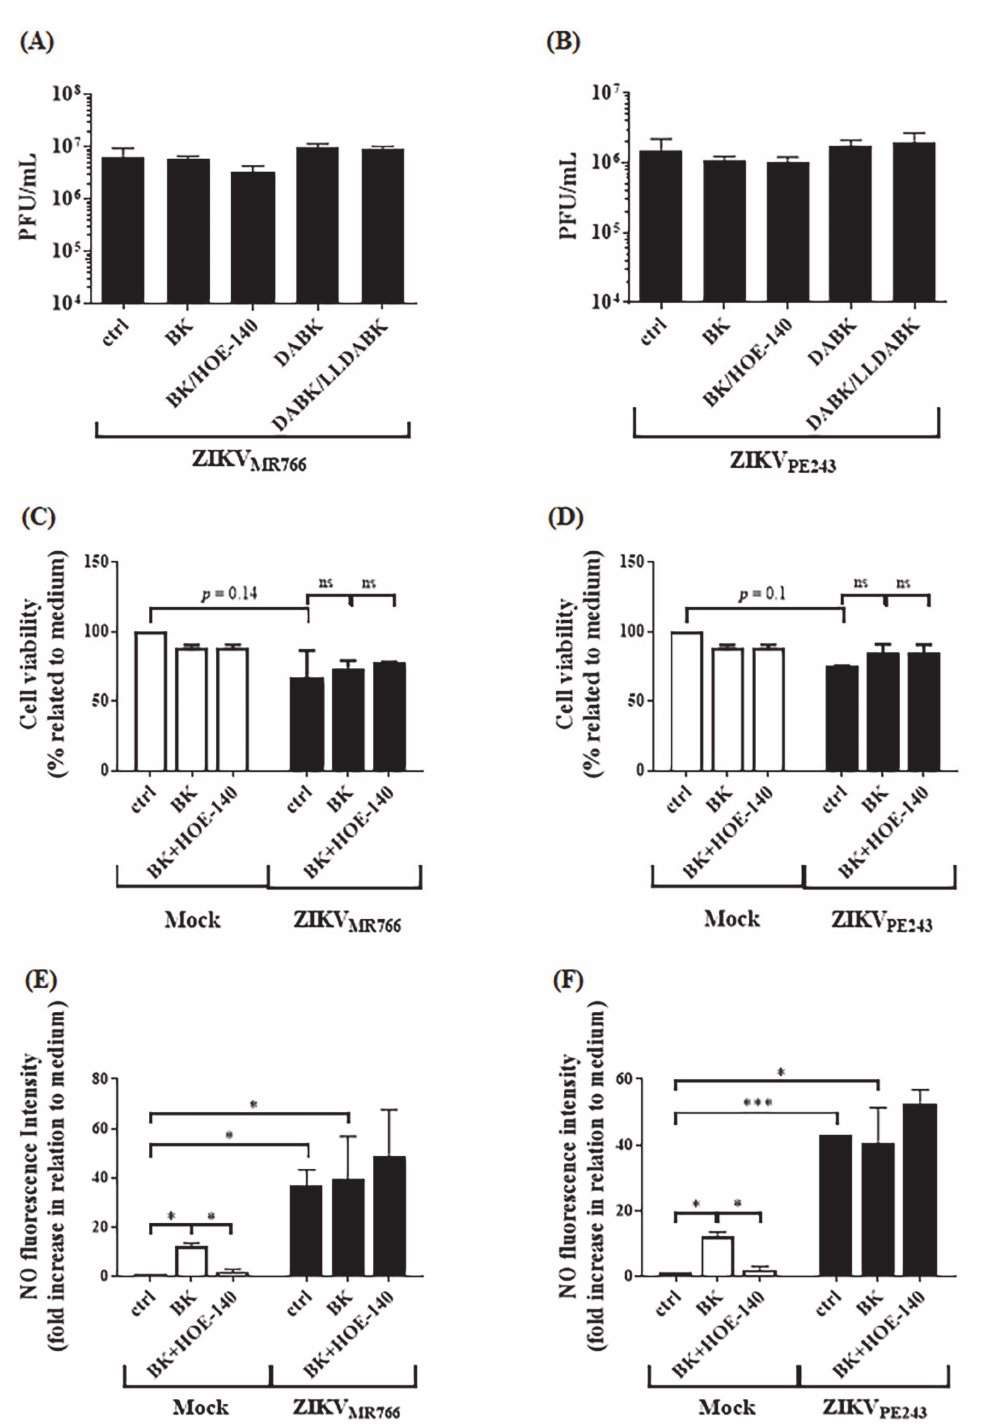
Figure 5. Bradykinin does not affect ZIKV replication. HBMECs were mock-treated or infected with ZIKV MR766 ( A , C , E ) or ZIKV PE243 ( B , D , F ). ( A , B ) At 24 h.p.i., the cells were treated with BK or DABK, in the presence or absence of the B2R or B1R antagonists-HOE-140 or LLDABK, respectively. Viral replication was evaluated at 48 h.p.i. by plaque assay. ( C – F ) At 24 h.p.i., ZIKV-infected HBMECs were treated with BK in the presence or absence of HOE-140. At 48 h.p.i., cell viability was assessed by XTT metabolization assay ( C , D ) and NO production was measured by immunofluorescence after DAF probe staining ( E , F ). The data are representative of three independent experiments. * represents p ≤ 0.05; *** p ≤